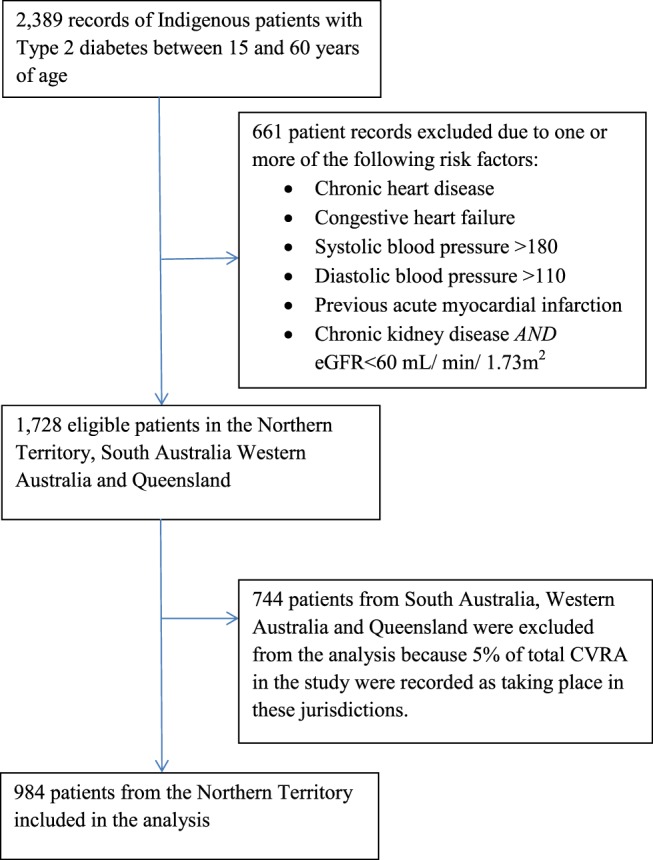
Enrollment of Aboriginal and Torres Strait Islander patients with Type 2 diabetes into the study.